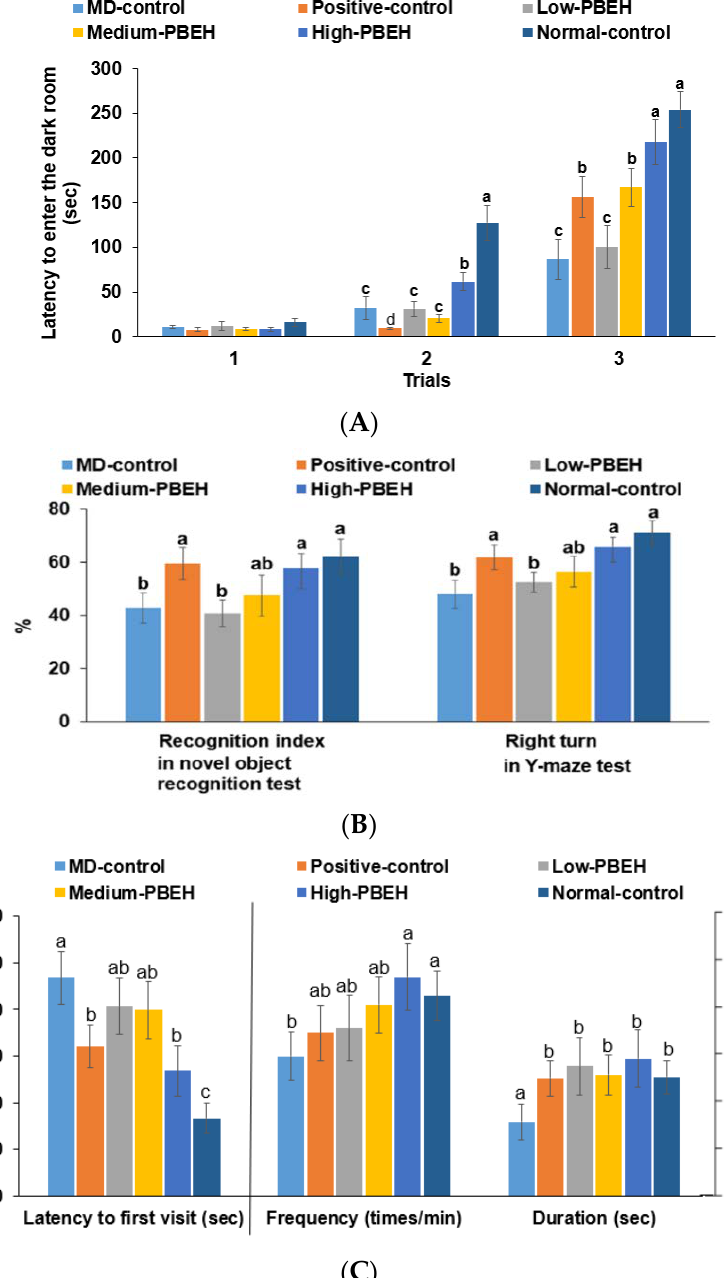
Figure 1. Memory deficits in rats after scopolamine injection. Male rats had intraperitoneal injections of scopolamine (2 mg/kg body weight/day) at 30 min after daily feeding of casein (MD-control), porcine brain enzyme hydrolysates (PBEH; 7 mg total nitrogen/mL) at 0.053 mL (Low-PBEH), 0.159 mL (Medium-PBEH), 0.478 mL (High-PBEH), or 10 mg donepezil (Positive-control) per kilogram body weight per day for six weeks. ( A ) Latency time to enter the dark box (s) during the first, second, and third trials; ( B ) novel object recognition index during novel objective recognition test and the number of the right turns among the total turns in the Y-maze test; ( C ) latency time to the first visit, frequencies to visit zone 5, and duration in zone 5. The bars and error bars represent the means ± standard deviations ( n = 10). a,b,c Different superscript letters on the bars indicate a significant difference among the groups according to a Tukey test at p < 0.05.